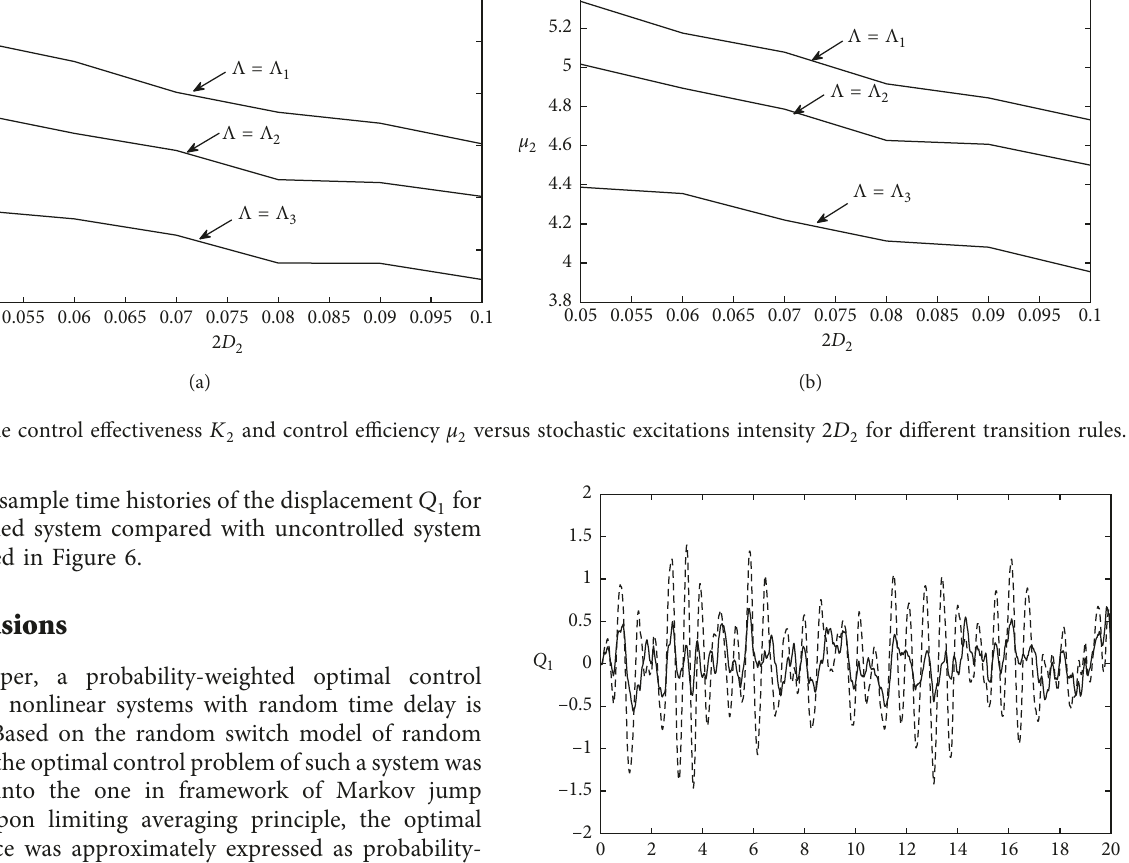
versus stochastic excitations intensity 2 D 1